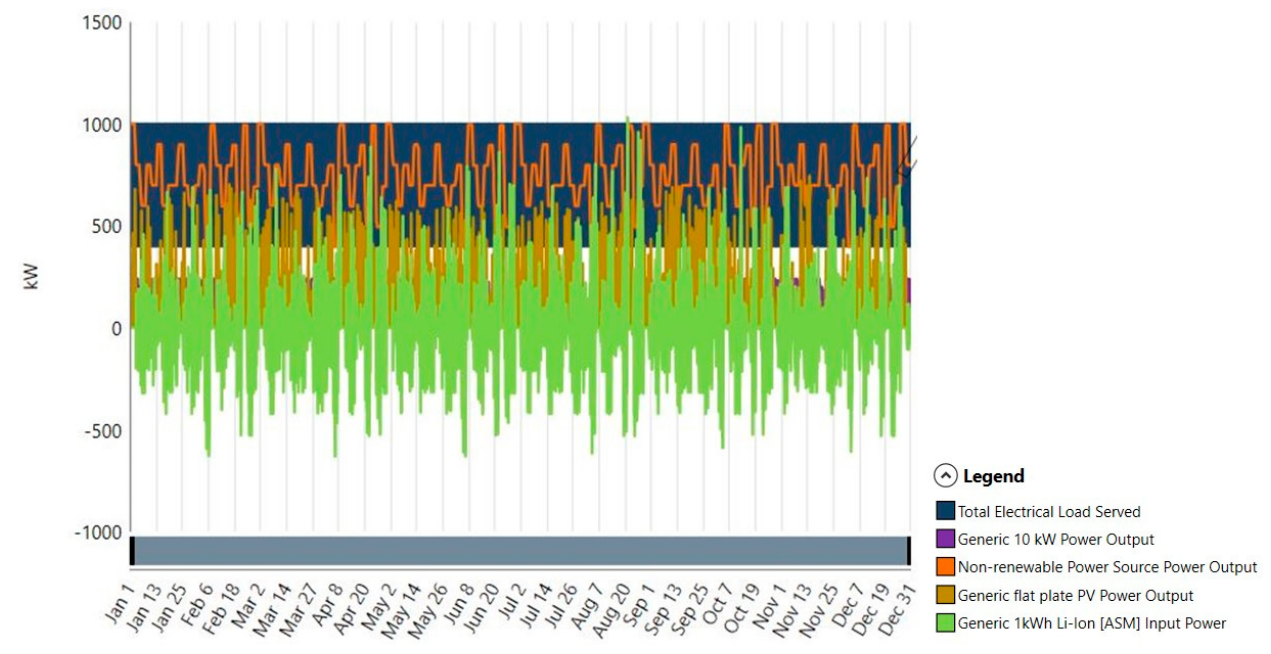
Figure 24. N-R HES energy flow.